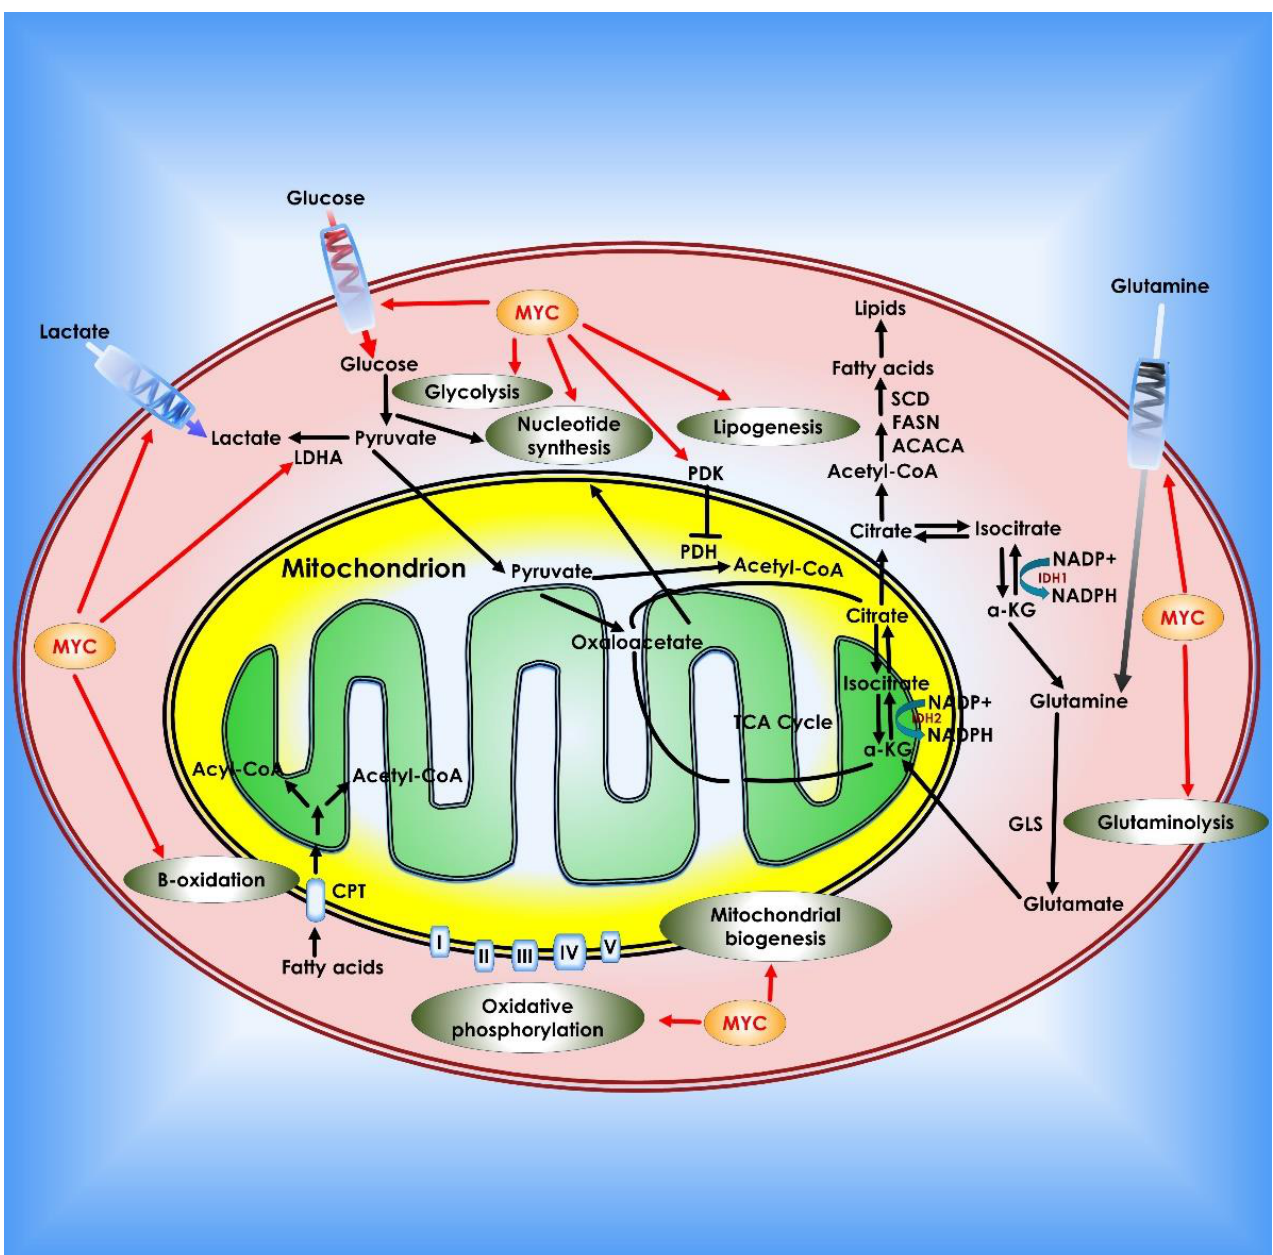
Figure 6. Role of c-Myc in cancer metabolism. Myc contributes to tumor cell metabolic reprogramming on several levels. Myc enhances the Warburg effect by boosting glucose absorption by